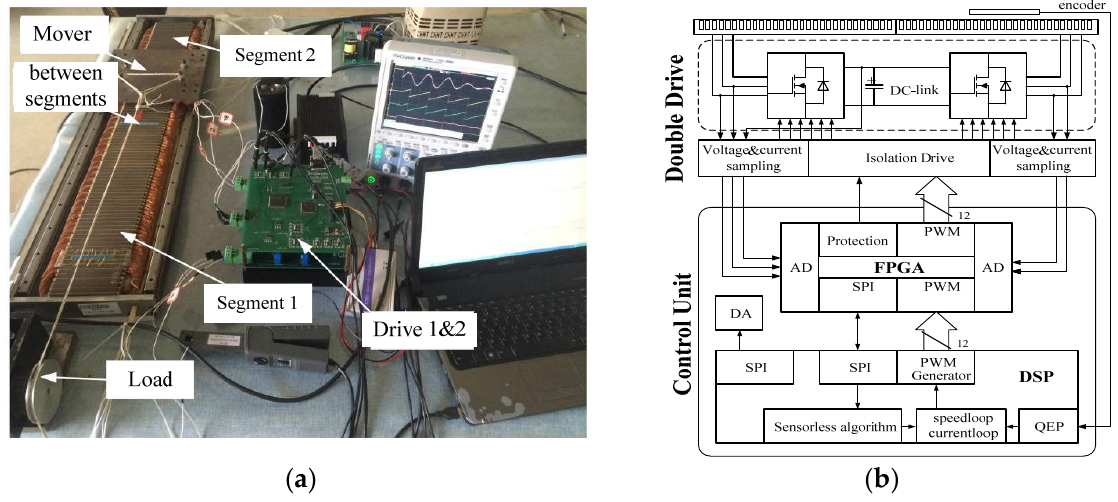
Figure 10. The platform of the WS-PMLM drive. ( a ) The experiment platform in the WS-PMLM drive. ( b ) Block diagram of the drive and control system.